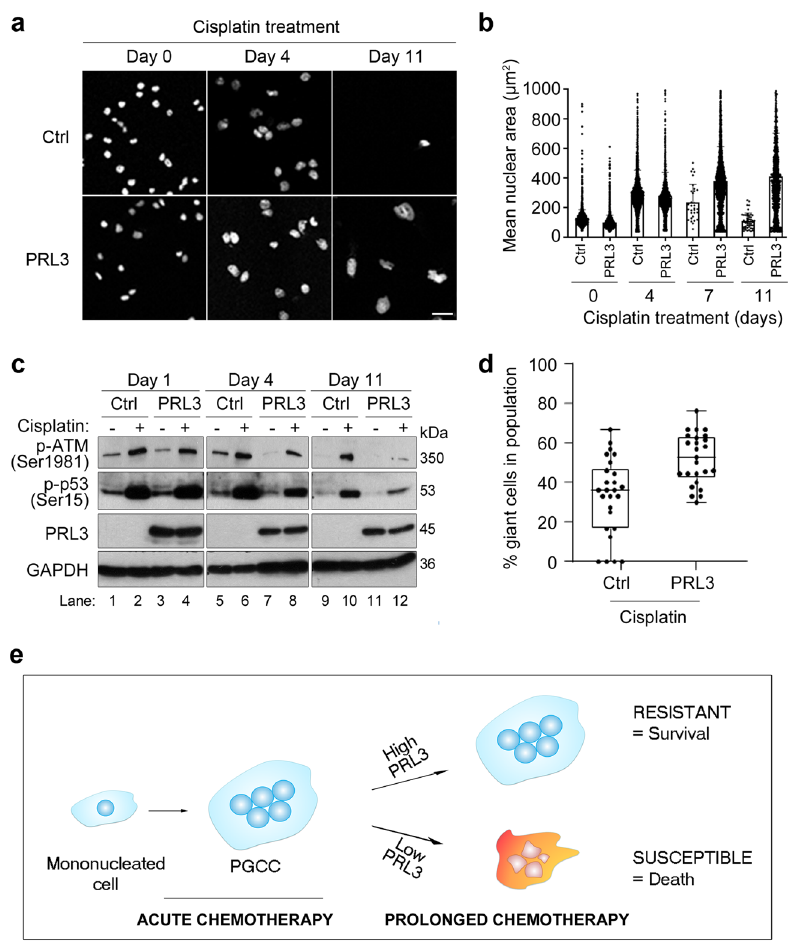
Fig. 3 PRL3 promotes chemo-resistance by inducing PGCCs formation. a Phase-contrast images demonstrating enhanced CHO-PRL3 ( ‘ PRL3 ’ ) cell survival after 11 days of cisplatin treatment compared to CHO-GFP ( ‘ Ctrl ’ ) cells. Bar, 100 µ m. b Graph showing changes in the mean nuclear area of cells ( a ) over the course of cisplatin treatment. Results presented as mean ± SD. P = 0.05 (two-way ANOVA), P < 0.0001 PRL3 vs. Ctrl at Day 11 (Student ’ s t -test) ( c ) Western blot analysis of cells left untreated or treated with 5 µ g/mL cisplatin for up to 11 days. GAPDH served as a loading control. d Chart presenting the mean percentage (%) of giant cells in the population of cisplatin-treated Ctrl and PRL3-overexpressing cells. n = 26 per group; P = 0.0002, Student ’ s t - test. e A hypothetical model showed how PRL3 promotes resistance during prolonged cisplatin treatment by enhancing PGCC